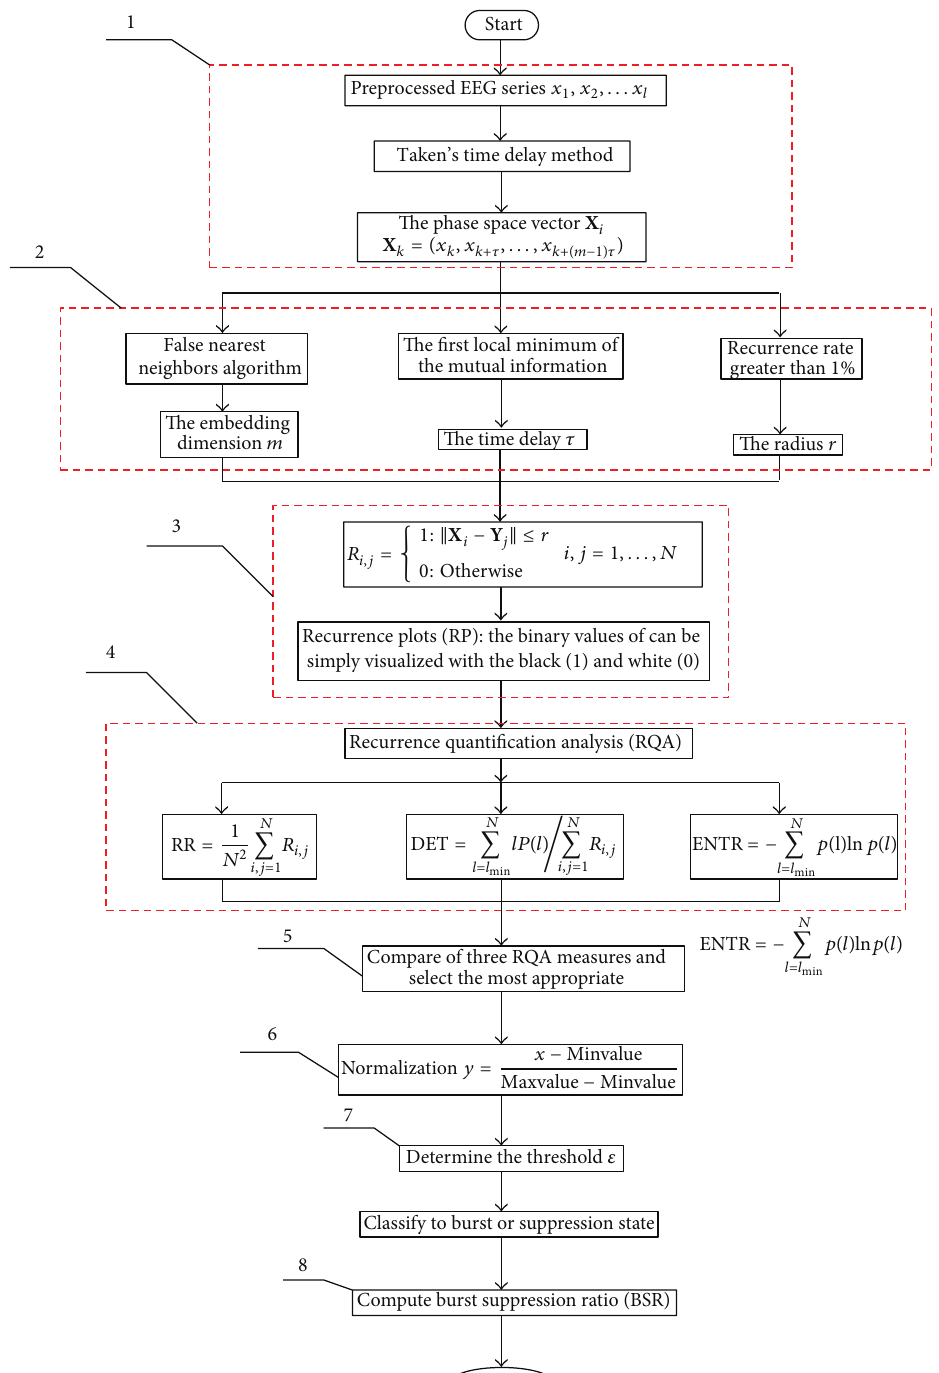
Figure 1: The block diagrams of EEG signal